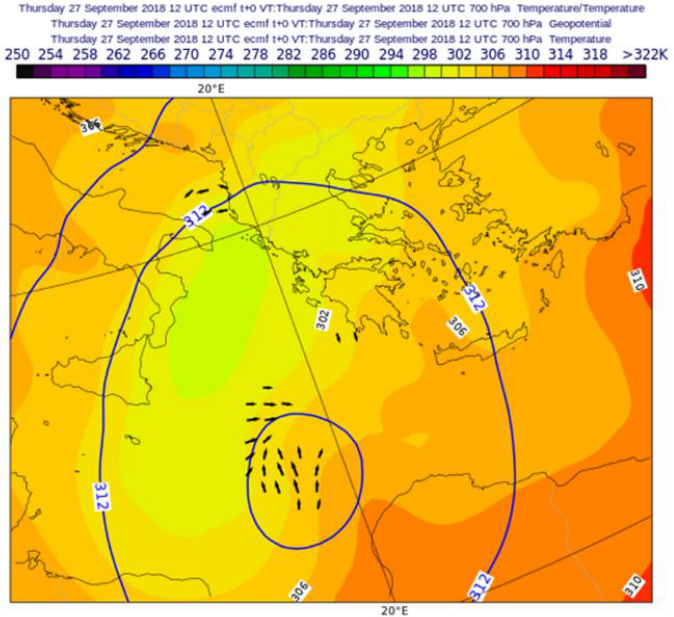
Figure 10. Q-vectors (units s − 3 and scaling × 10 11 ), potential temperature (coloured areas; in K), and geopotential height (continuous lines; in gpdam) at 700 hPa for 27/12 UTC.